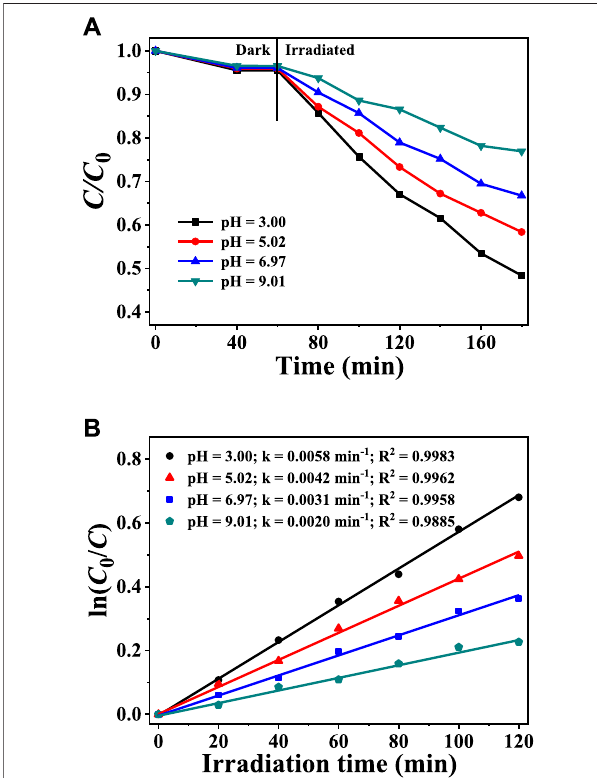
FIGURE 7 | (A) Adsorption and photocatalytic reduction of Cr(VI) over CuInS 2 undervisibleirradiationinthemixedsolutionwithdifferentweightratios ofCr(VI)andCAP (B) CorrespondingkineticsplotsforthephotocatalyticCr(VI) reduction reactions in (A) . ([Cr(VI)] = 10 mg/L, [catalyst] = 0.2 g/L; pH =